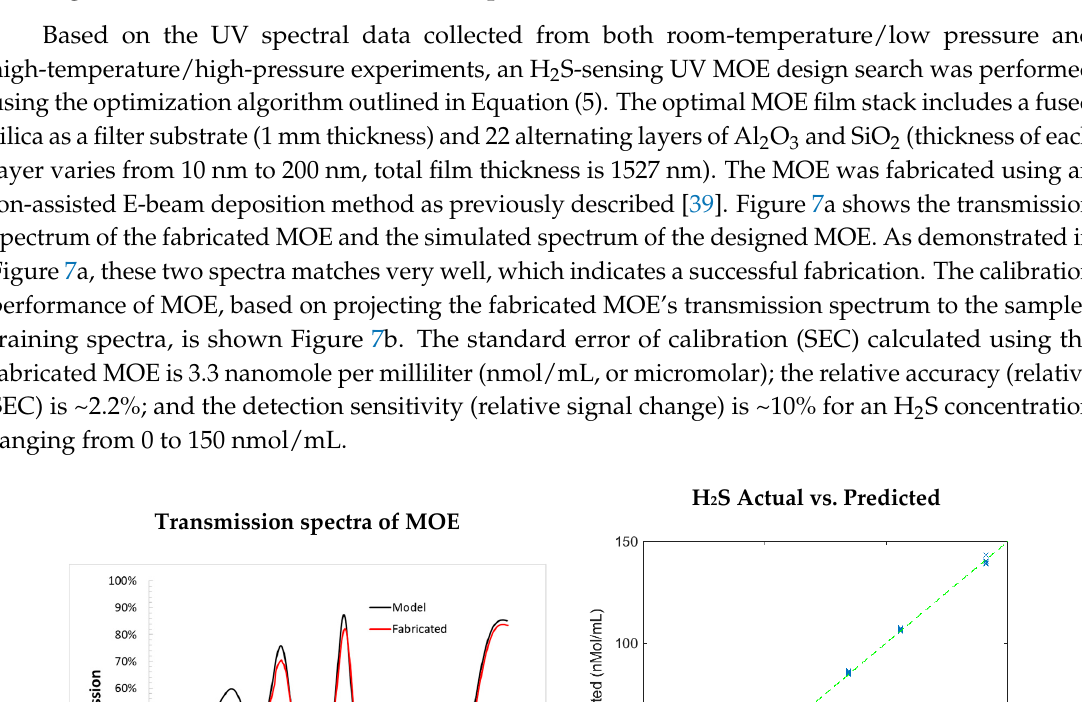
Figure 6. Normalized spectra of 10 ppm H 2 S sample at various high temperatures and high pressures (pressures: 20.68, 41.37, 60.05, 82.73, and 103.42 MPa; temperatures: 65.6, 93.3, 121.1, 148.9, and 176.7 °C).